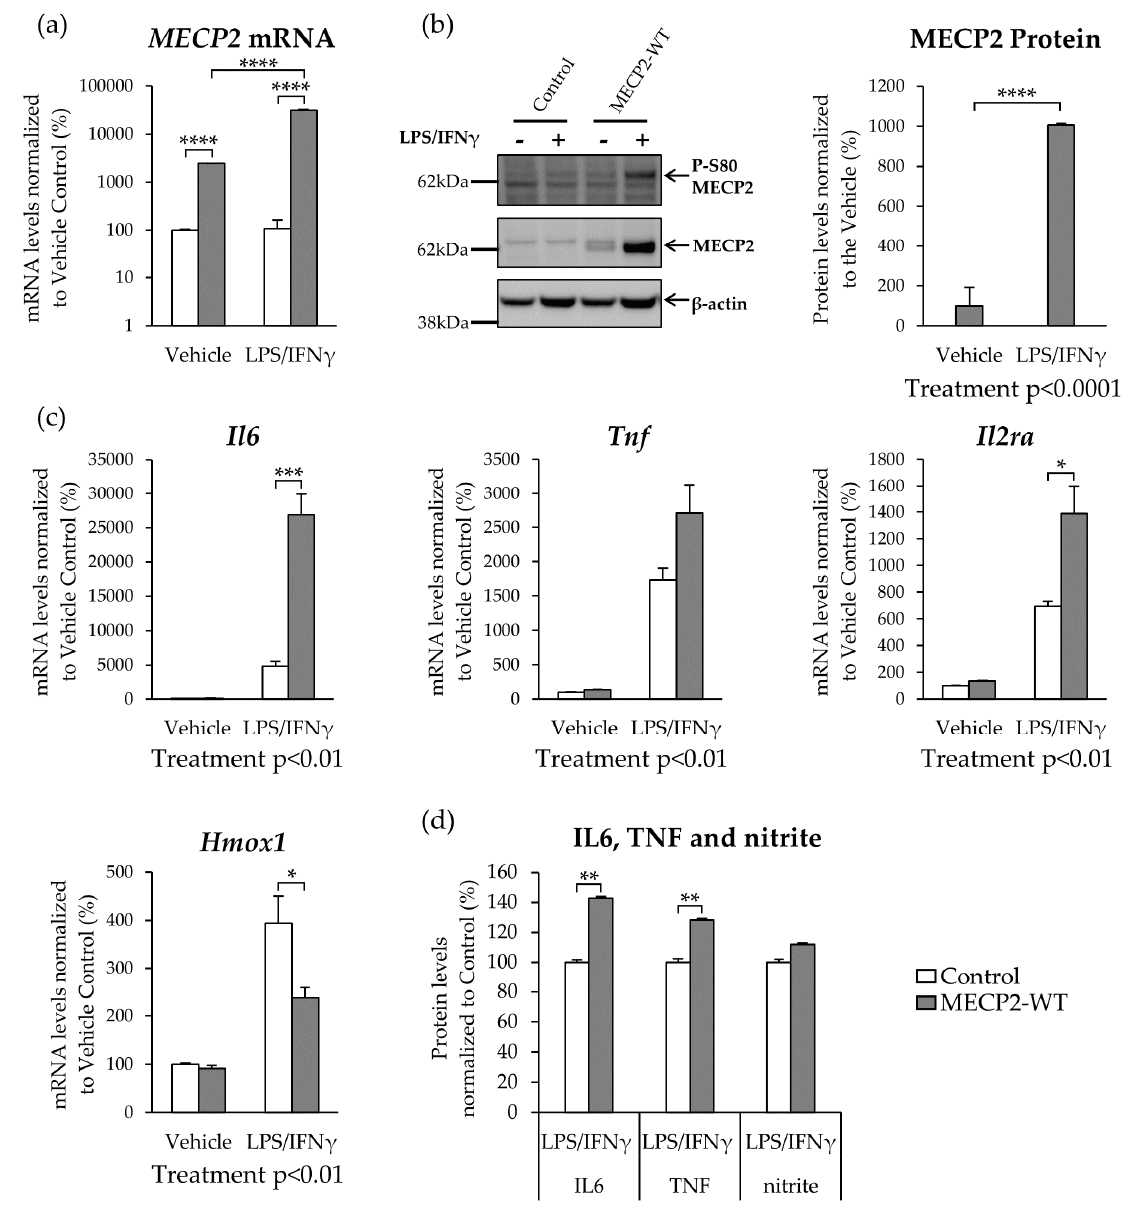
Figure 2. MECP2 overexpression increases the expression of pro-inflammatory cytokines in BV2 cells upon lipopolysaccharide (LPS) and interferon- γ (IFN γ )-induced inflammation. BV2 cells were transduced with lentivirus vectors encoding MECP2-Myc-DDK or tags only (Control) under human cytomegalovirus (CMV) promoter. Inflammation was induced by treatment with LPS (200 ng/mL) and IFN γ (20 ng/mL) for 24 h. ( a ) Gapdh -normalized MECP2 mRNA expression. Data are shown as mean + SEM of n = 3. One-way ANOVA, post-hoc LSD; **** p < 0.0001. ( b ) A representative Western blot image showing MECP2-Myc-DDK overexpression (anti-Myc tag primary antibody) and phosphorylation at serine 80 (S80) epitope in vehicle and LPS/IFN γ -treated BV2 cells (left). Quantification of β -actin -normalized exogenous MECP2 protein levels (right). Data are shown as mean + SEM of n = 7 of two independent experiments. Independent samples t-test; **** p < 0.0001. ( c ) Gapdh -normalized mRNA expression of pro-inflammatory cytokines Il6 , Tnf , and Il2ra , and anti-inflammatory Hmox1 . Data are shown as mean + SEM of n = 7 of two independent experiments. Independent samples t-test or independent samples Mann–Whitney U test; * p < 0.05, ** p < 0.01, *** p < 0.001. ( d ) IL6, TNF and nitrite levels in the conditioned medium of BV2 cells. Data are shown as mean + SEM of n = 7 of two independent experiments. Independent samples t-test; ** p < 0.01.